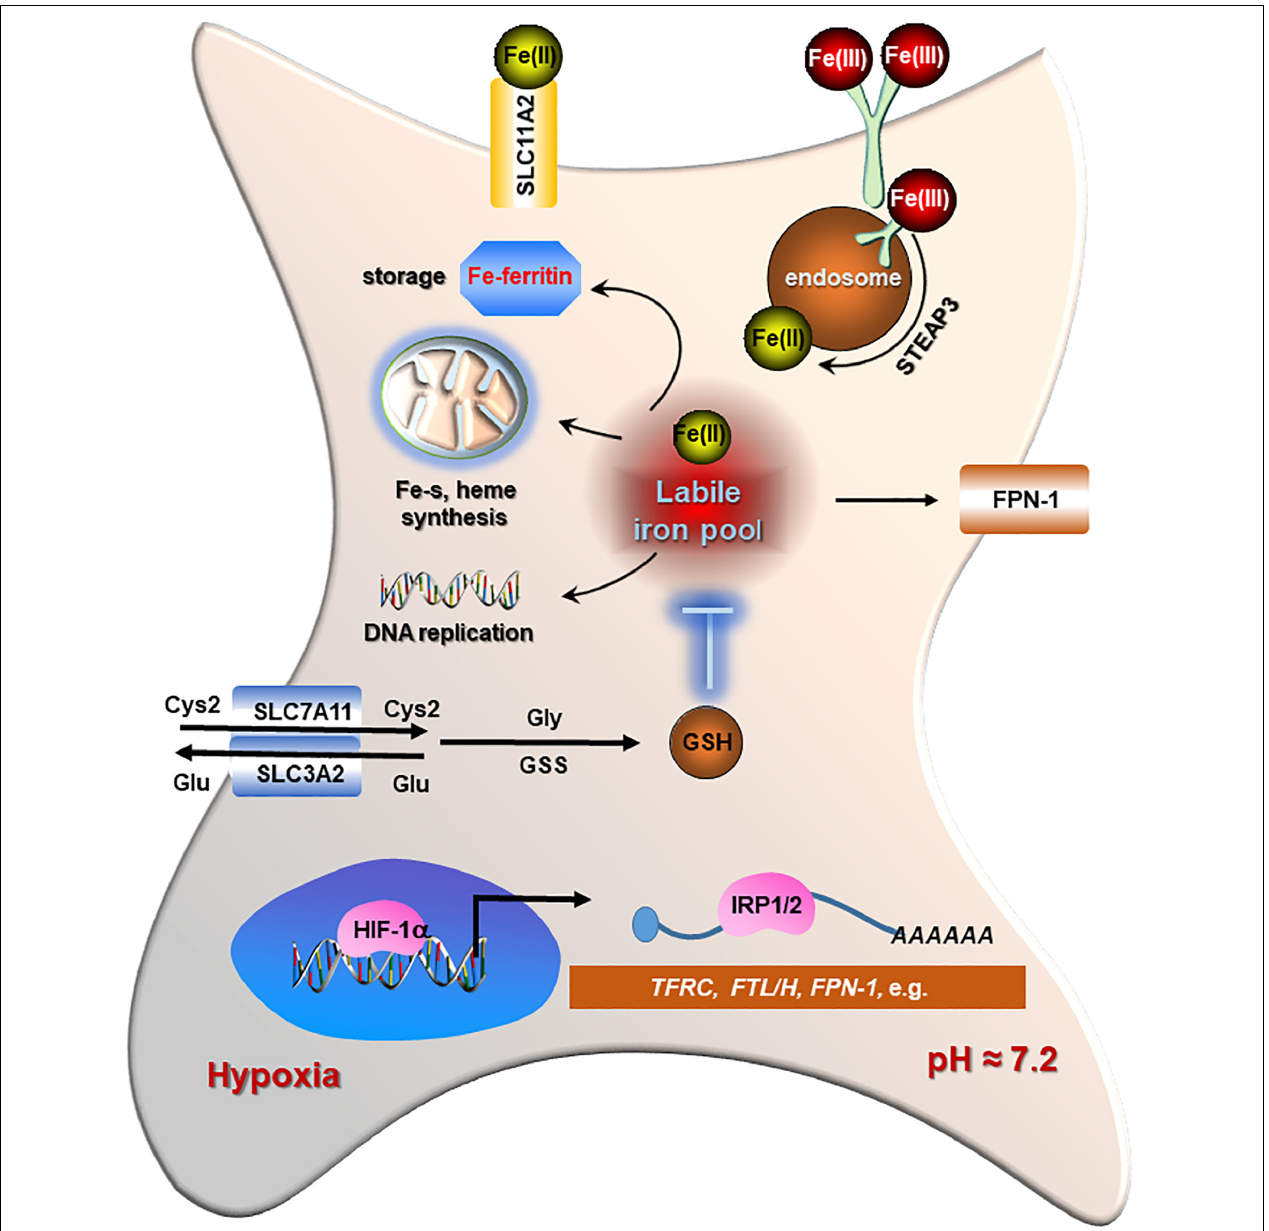
FIGURE 2 | The regulations of iron metabolism and redox homeostasis in cancer cells. Cancer cells display higher iron transporting, storage, and bioavailability as well as increased levels of glutathione (GSH) and GPX4 for detoxification in contrast to normal cells. Iron regulatory proteins (IRP1/2) play a central role in maintaining an adequate iron homeostasis in cancer cells by regulating the stability of each mRNA differentially [increasing for transferrin receptor 1 (TFRC) and SLC11A2, while decreasing for light chain (FTL)/H protecting cells]. The classical marker of hypoxia, HIF-1 α , also supports the stabilization of TFRC, IRP1/2, as well as FTL/H to promote both iron absorption and availability in cancer